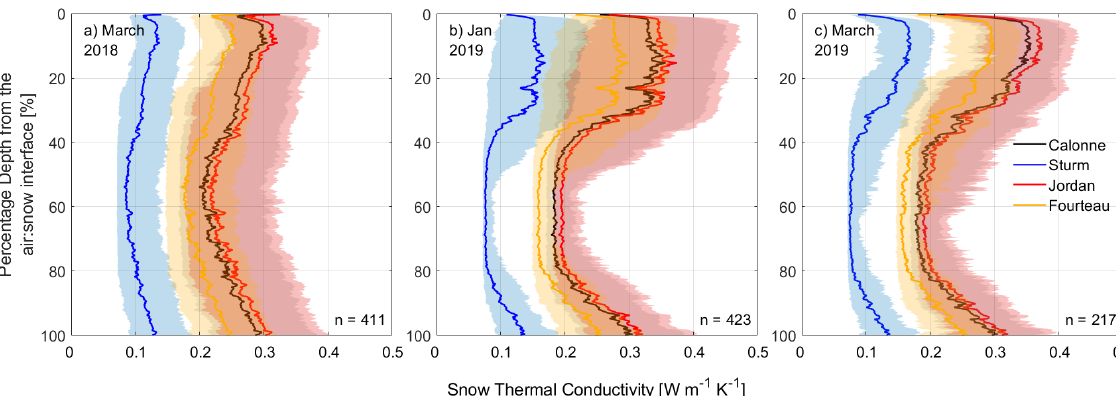
Figure 4. Median thermal conductivity profiles (lines) and interquartile range (shaded areas) approximated from SMP densities, using the parameterisations of Calonne et al. (2011) in black/grey, Sturm et al. (1997) in blue, Jordan (1991) in red and Fourteau et al. (2021b) in yellow.